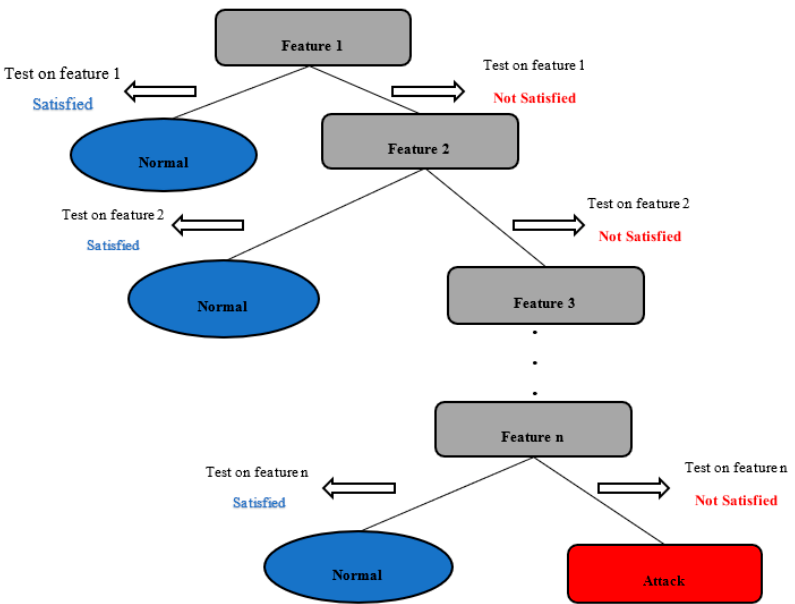
Figure 2. DT algorithm for binary classification.